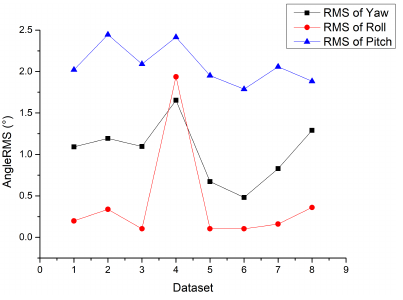
Figure 11. The attitude RMS of datasets.